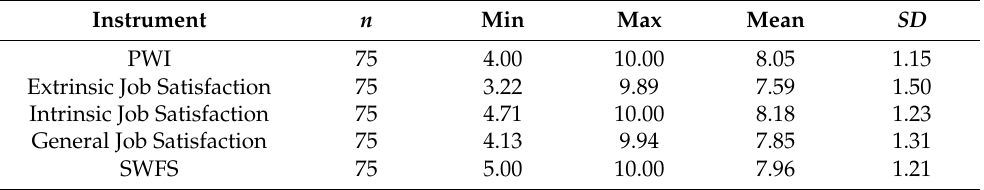
Table 2. Descriptive Aggregated